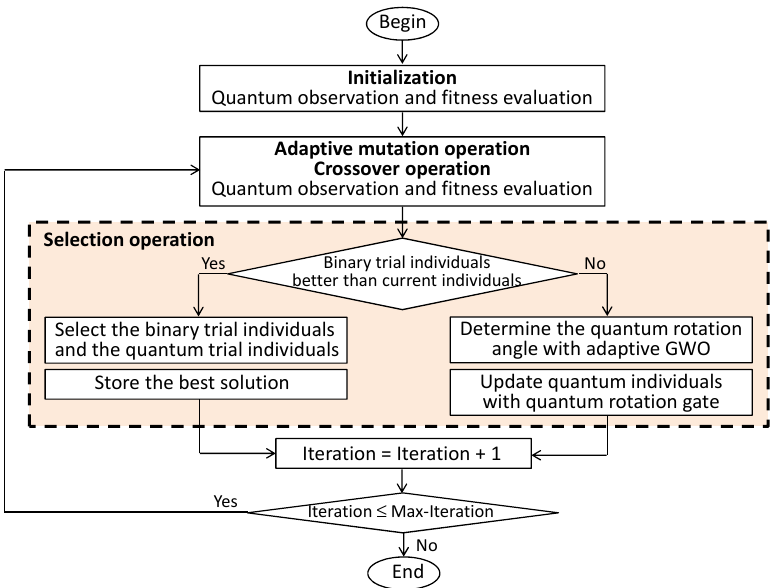
Figure 4. Framework of QDGWO (Quantum-inspired Differential (QD) evolution with adaptive Grey Wolf Optimizer (GWO)).